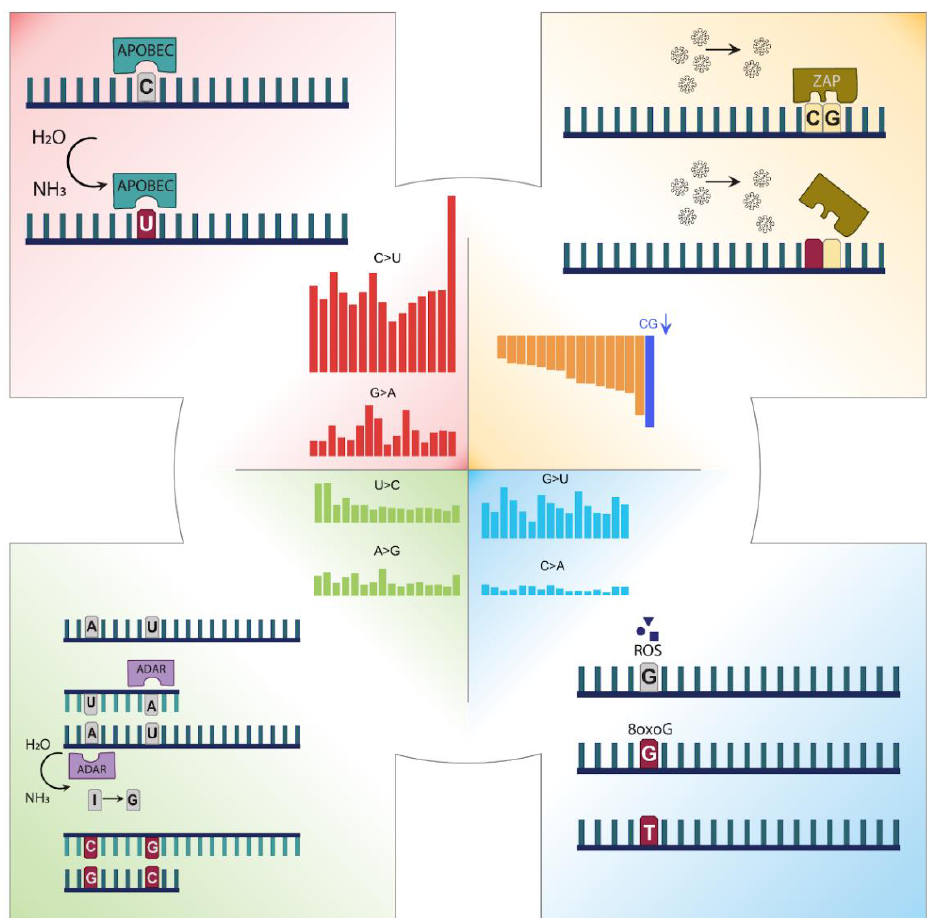
Figure 5. Mechanisms that can alter the sequence context of SARS-CoV-2. (i) APOBEC-caused mutations correlated with the enzyme signature dominantly on the plus RNA strand; (ii) ADAR-caused mutations equivalently affecting both RNA strands due to its mechanism of action; (iii) drop of CG dinucleotide targeted by ZAP through selection; (iv) ROS effect shown on the plus RNA